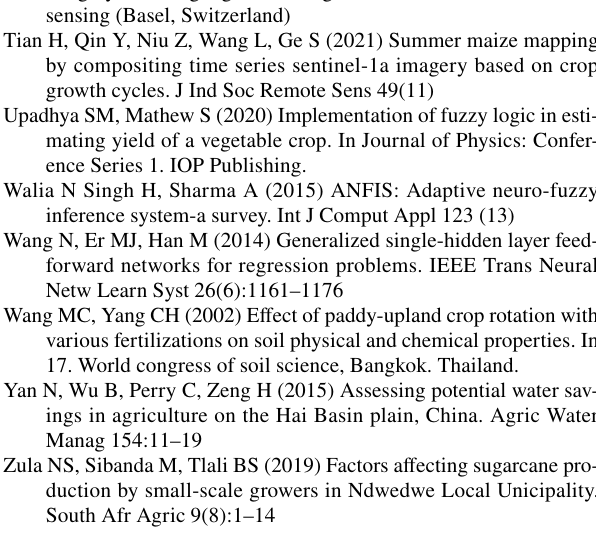
Tabatabaei S, Shakeri E, Nasiri H (2015) Effect of different method irrigation and manure on reduce water use in the planting grain maize cv. Ksc704 Iran J Field Crops Res 12(4):766–775 Taliei A, Bahrami N (2002) The effect of rainfall and temperature on dryland wheat yield in Kermanshah province. Soil Water Sci